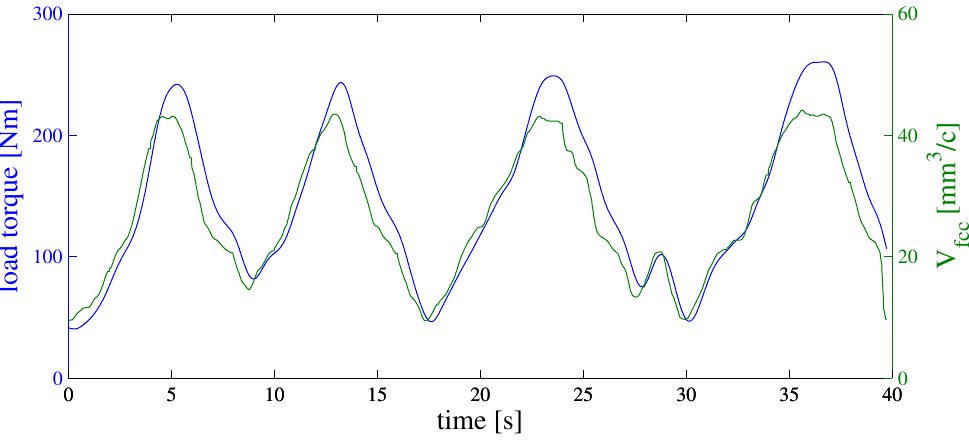
Figure 14. Validation cycle at constant engine speed of 1950 rpm. V injected per cycle per cylinder.